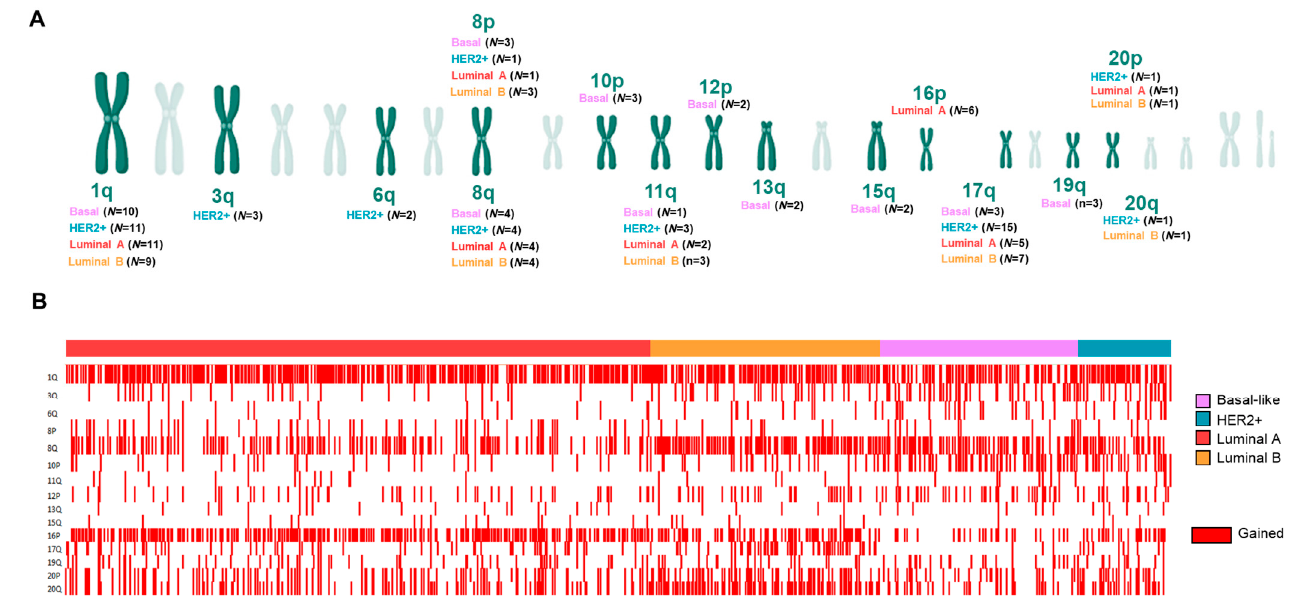
Figure 3. Number of splicing-related genes with high amplification in >5% of patients by chromosome location ( A ) (Created with BioRender.com (accessed on 4 December 2019)). Tumors with chromosomal gain (red) in each molecular subtype ( B ).